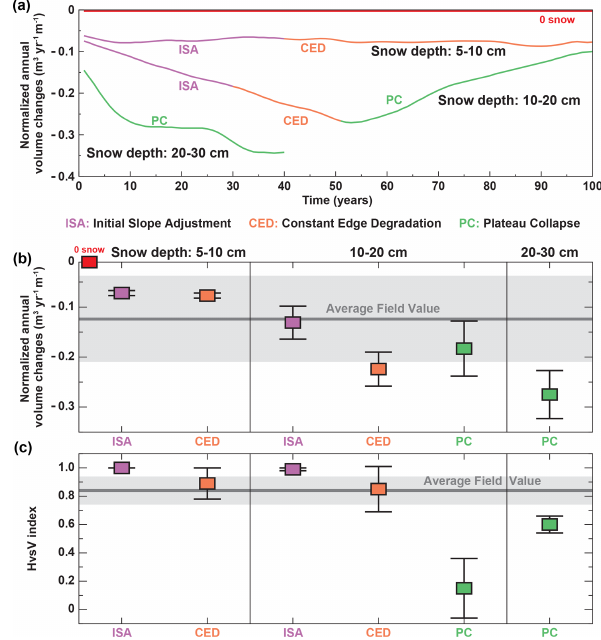
Figure 9. (a) Normalized annual volume changes for the three snow scenarios. (b) Comparison of volume changes and shape index be- tween observations and simulations. Observations (gray line and shading) are means and standard deviations of the variables in the eight edge transect areas presented in Table 1. The values derived from simulations are mean and standard deviations taken over the different periods of the simulations. See Fig. 8 and Sect. 4.2. for a description of the three degradation phases. No subsidence occurred for the 0 snow simulation (red